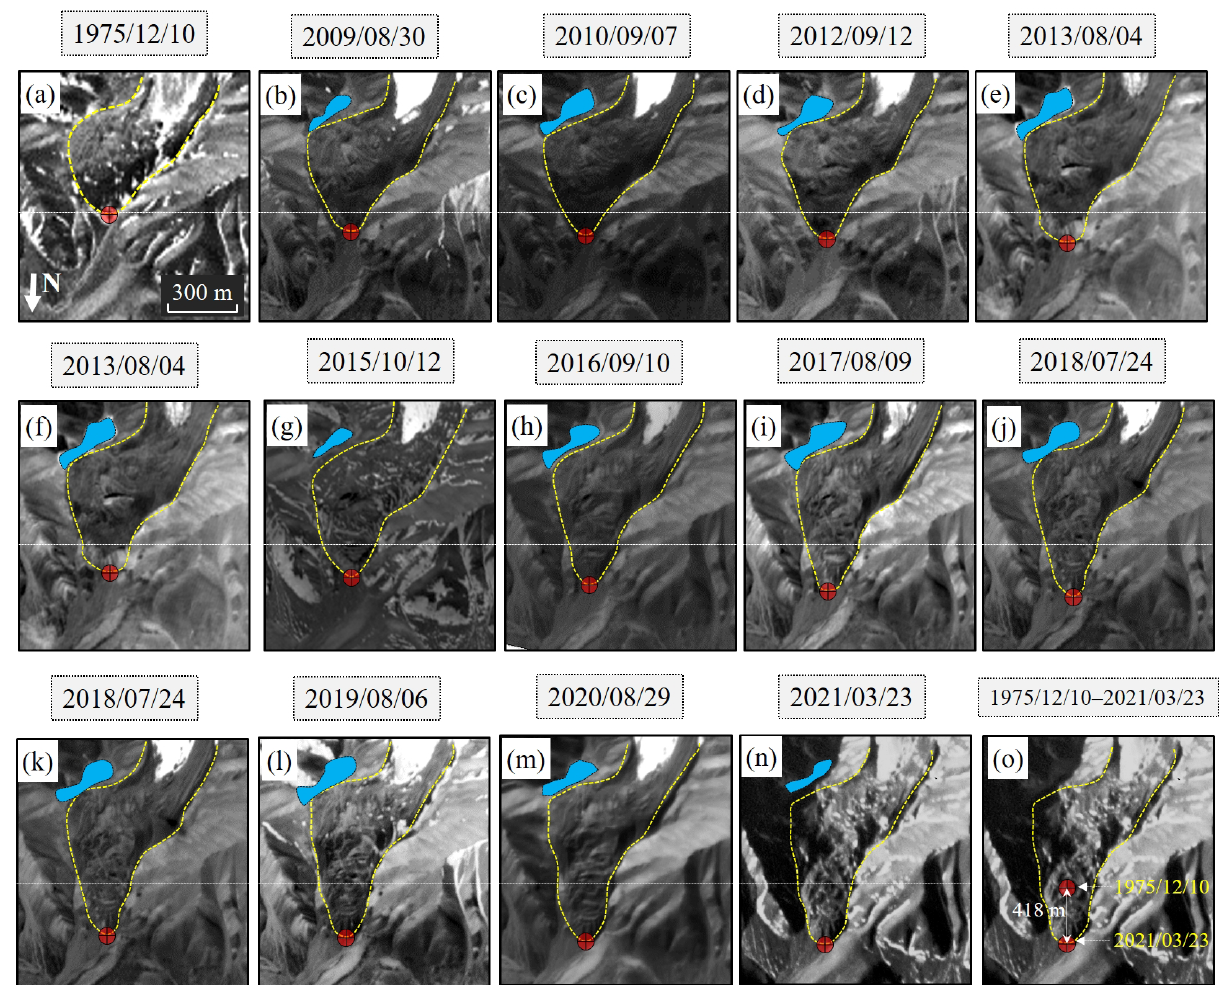
Figure 3. Optical satellite images covering the KLP-37 glacier tongue. (a) KH-9 Hexagon image acquired on 10 December 1975 (© US Geological Survey); (b–n) Planet images acquired between 7 September 2009 and 23 March 2021 (© Planet Labs); (o) comparison of the glacier terminus position between 1975 and 2021. The horizontal dotted white lines provide a reference for the terminus position in 1975. The blue polygons represent the ice-dammed glacier